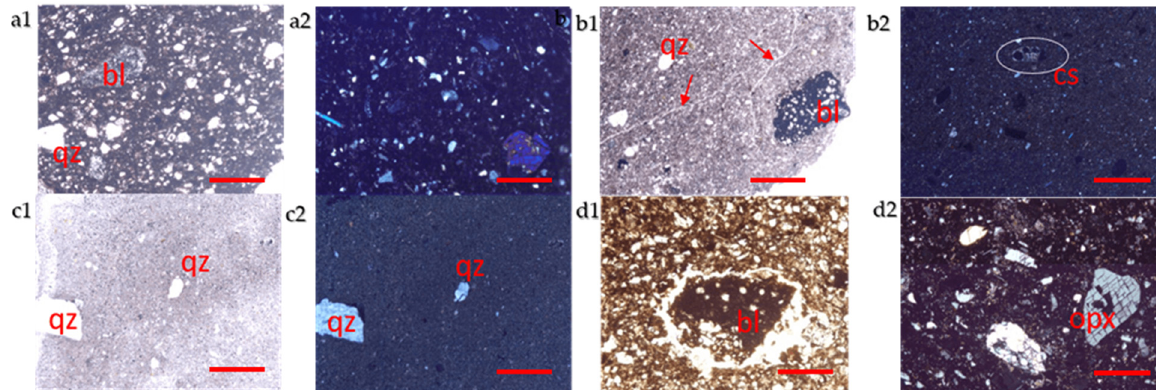
Figure 4. Mineralogical composition of representative brick samples for XRD analysis. Upper panel: sample B3 (yellow); below panel: sample B1 (red).